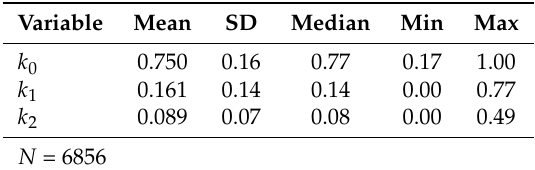
Table 9. Summary of ch 0 , ch 1 , and ch 2